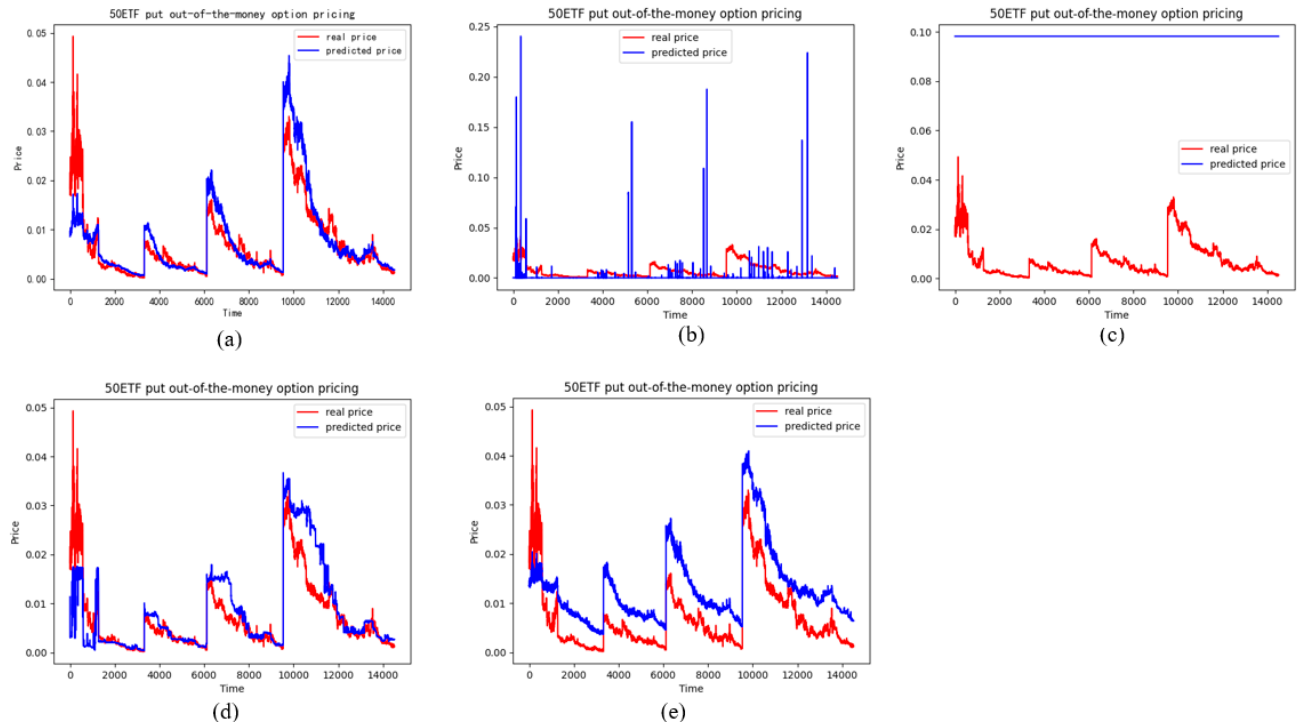
Figure 18. The pricing performance of OTM put options on each model ( a ) stands for the LSTM model, ( b ) stands for the BS model, ( c ) stands for the SVM model, ( d ) stands for the Random forests model, ( e ) stands for the RNN model.